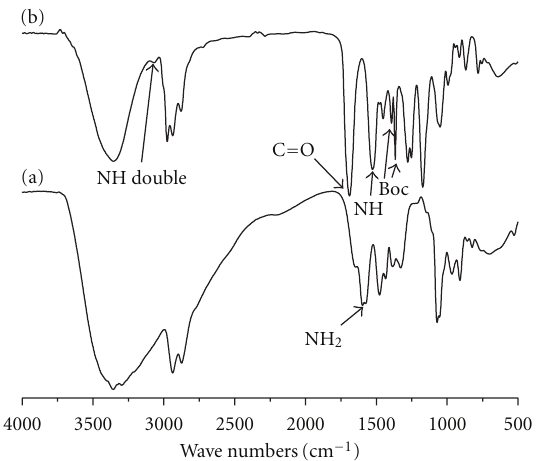
Figure 2: FT-IR spectra of 3-amino-1-propanol (a) and tert-butyl- N -(3-hydroxypropyl) carbamate (b).